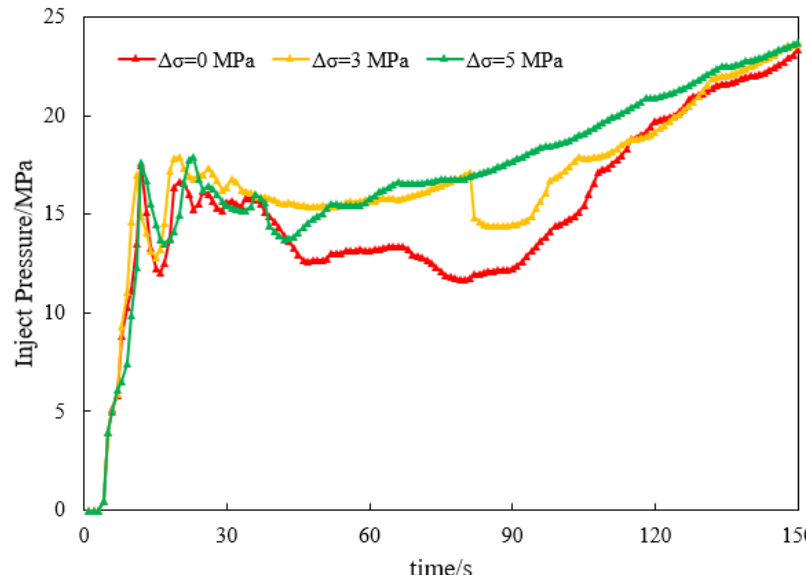
Figure 5. Displacement contour plot of the natural fracture network of group A at different moments under a stress difference of 0 MPa.